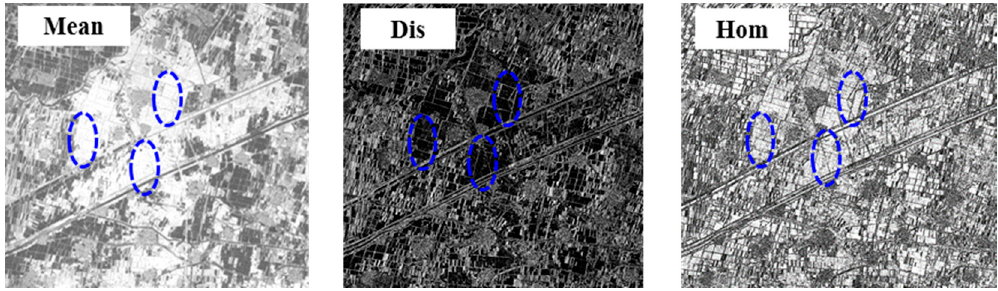
Figure 10. Example of different textural features extracted from the 8 m GF-1 imagery (In this figure, Dis is the abbreviation of dissimilarity and Hom is the abbreviation of homogeneity. Furthermore, the blue oval circled is PMF.).